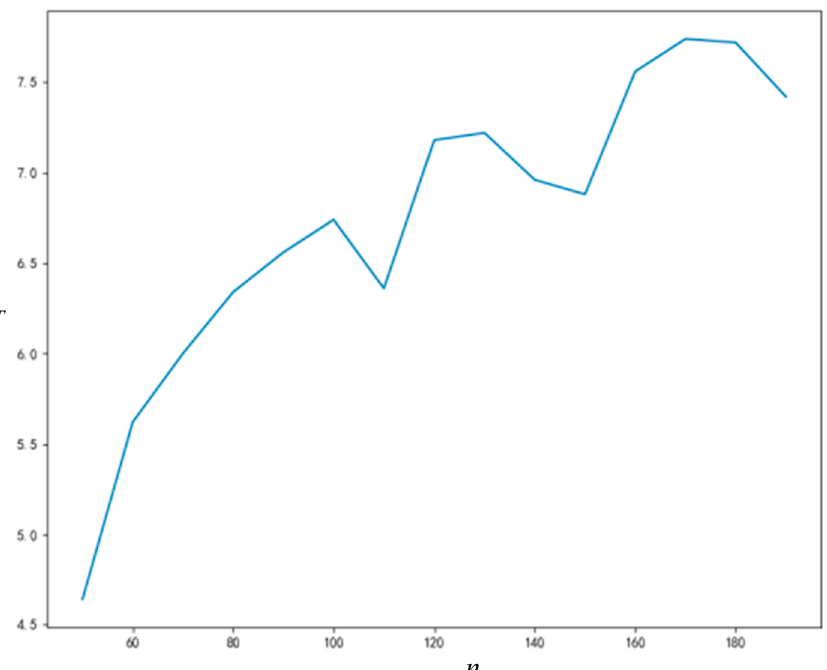
Figure 11. The relationship between node number and T .